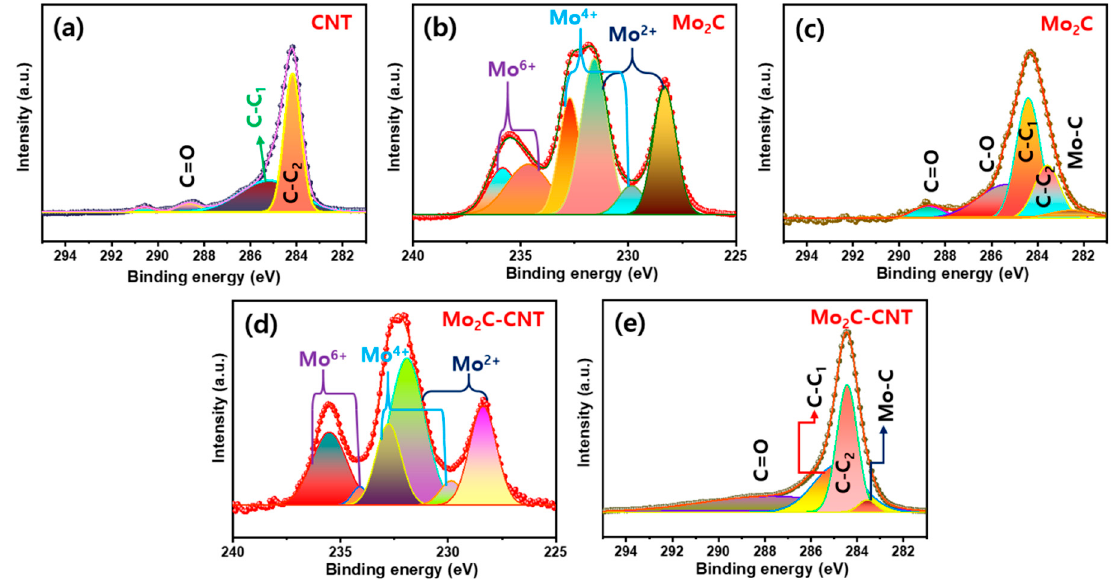
Figure 5. XPS results of ( a ) C 1s for CNT; ( b ) Mo 3d and ( c ) C 1s for Mo 2 C; and ( d ) Mo 3d and ( e ) C 1s for Mo 2 C@CNT.